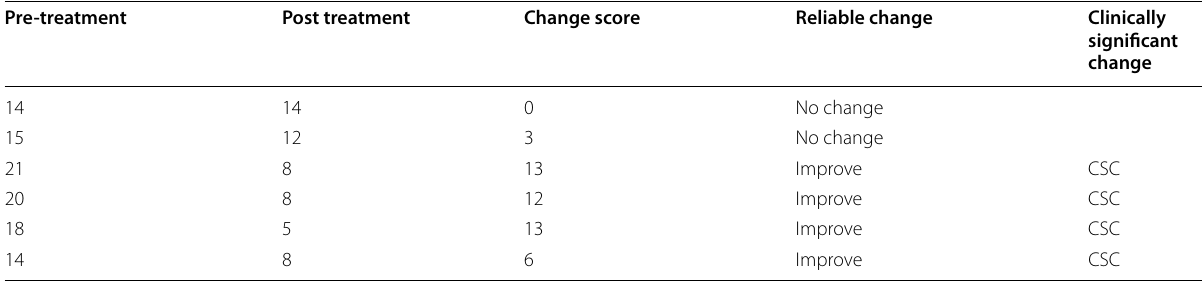
Table 2 Reliable improvement and clinically significant change in HADS Anxiety, per participant Pre-treatment